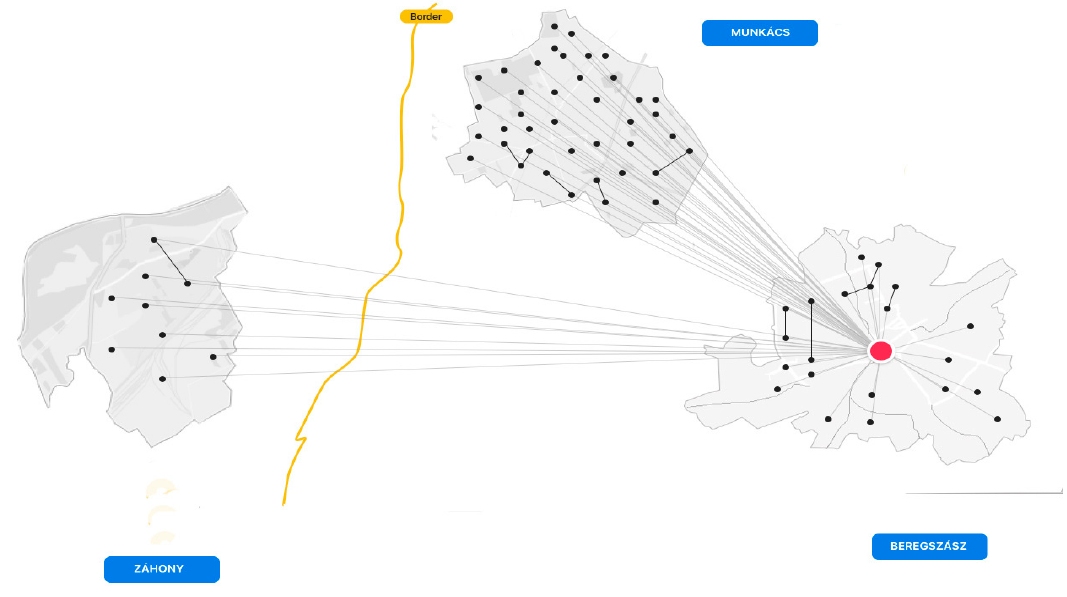
Figure 1. Networked space of NZBM. Source: Author.